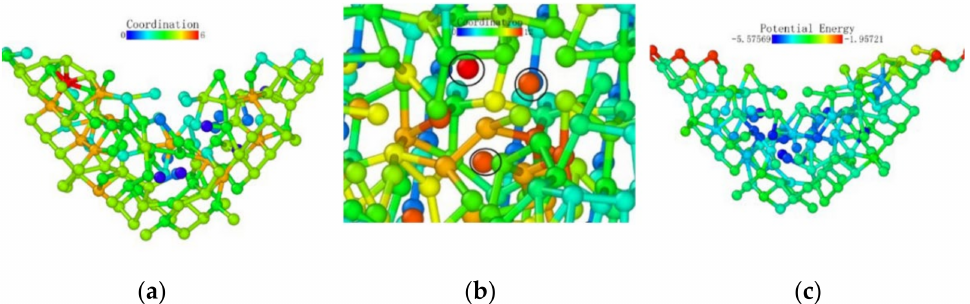
Figure 12. Distribution of coordination number and potential energy at a stroke of 1 nm: ( a ) cutoff radius 2.6 Å; ( b ) cutoff radius 3.2 Å; ( c ) potential energy